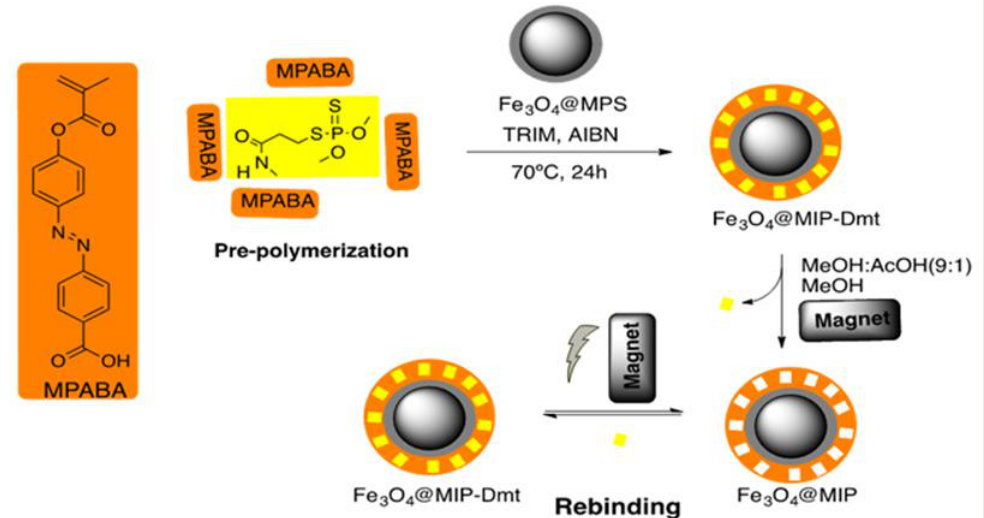
Figure 2. Synthetic pathway of the preparation of DR-MIP.